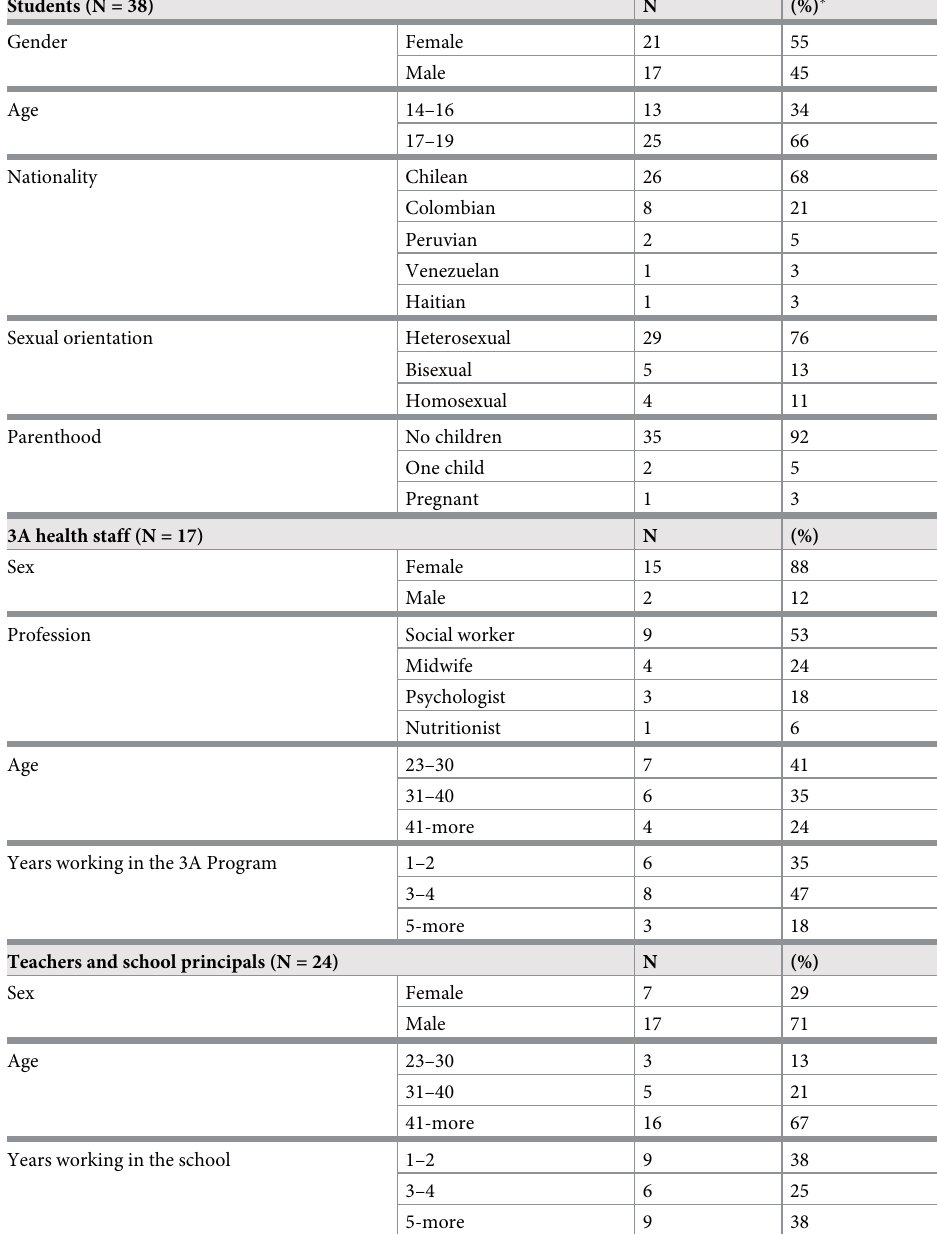
Table 1. Characteristics of participants in in depth-interviews and focus groups(N = 79).